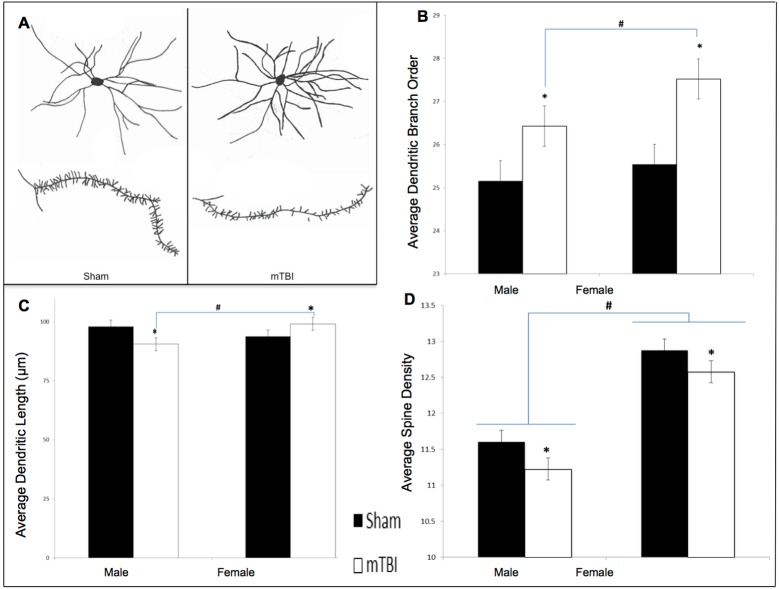
Neuroanatomical findings from STD animals for the NAc medium spiny neurons.A) exhibits a representative tracing of average medium spiny neurons and dendritic spines from the NAc in sham and mTBI animals; B) graphical representation of dendritic branch order from Golgi-Cox stained neurons; C) representation of average dendritic length, and D) is illustrative analysis of dendritic spine density; (*main effect of mTBI p < .05; # main effect of sex p < .05).